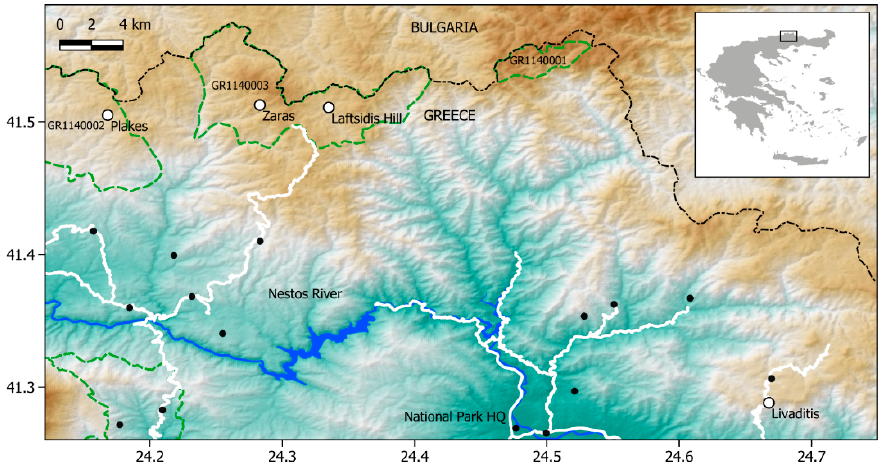
Figure 1. Location of the acoustic sensors (white points) within the Rhodope Mountain landscape [Black points mark main settlements, white lines the tar road network, and dashed green lines the Natura 2000 area boundaries].